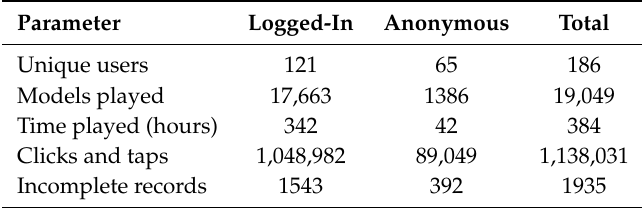
Table 3. General statistical data retrieved from log